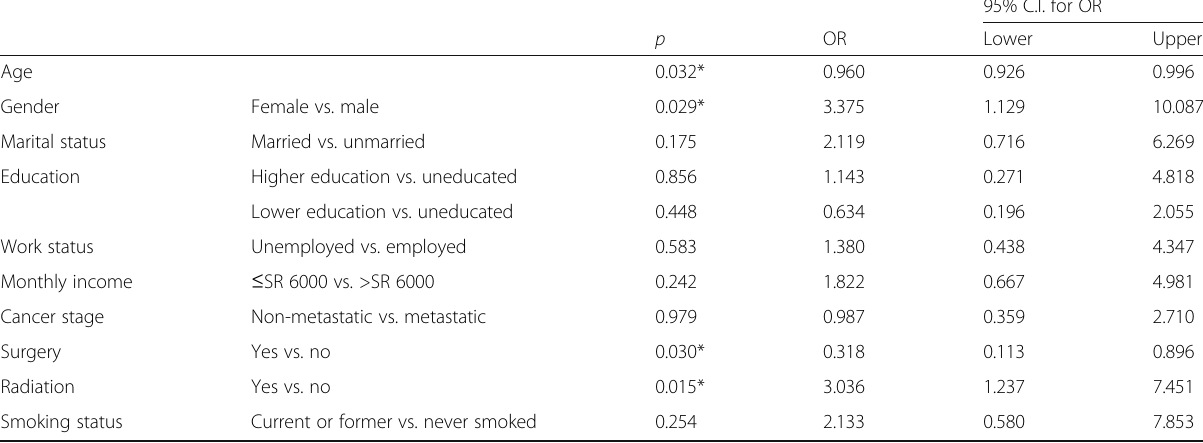
Table 4 Multivariate logistic regression analysis of between complementary and alternative medicine (CAM) use and demographic and clinical